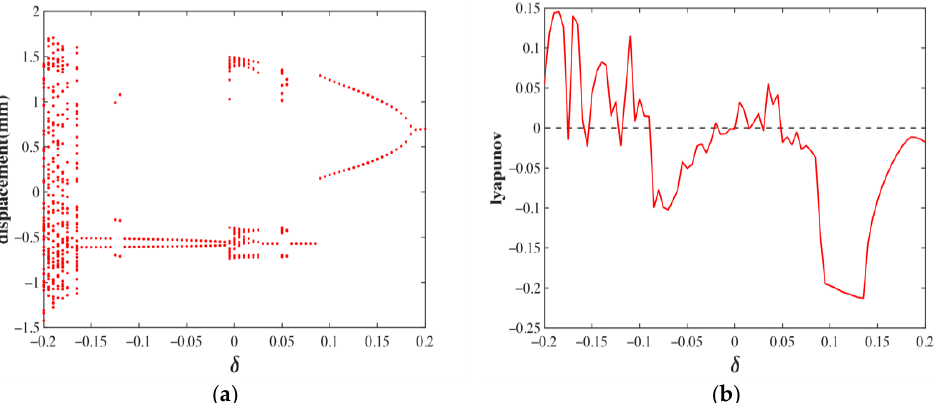
Figure 16. Bifurcation diagram and Lyapunov exponent diagram of the system with δ at α = 1: ( a ) Bifurcation diagram; ( b ) Lyapunov exponent diagram.